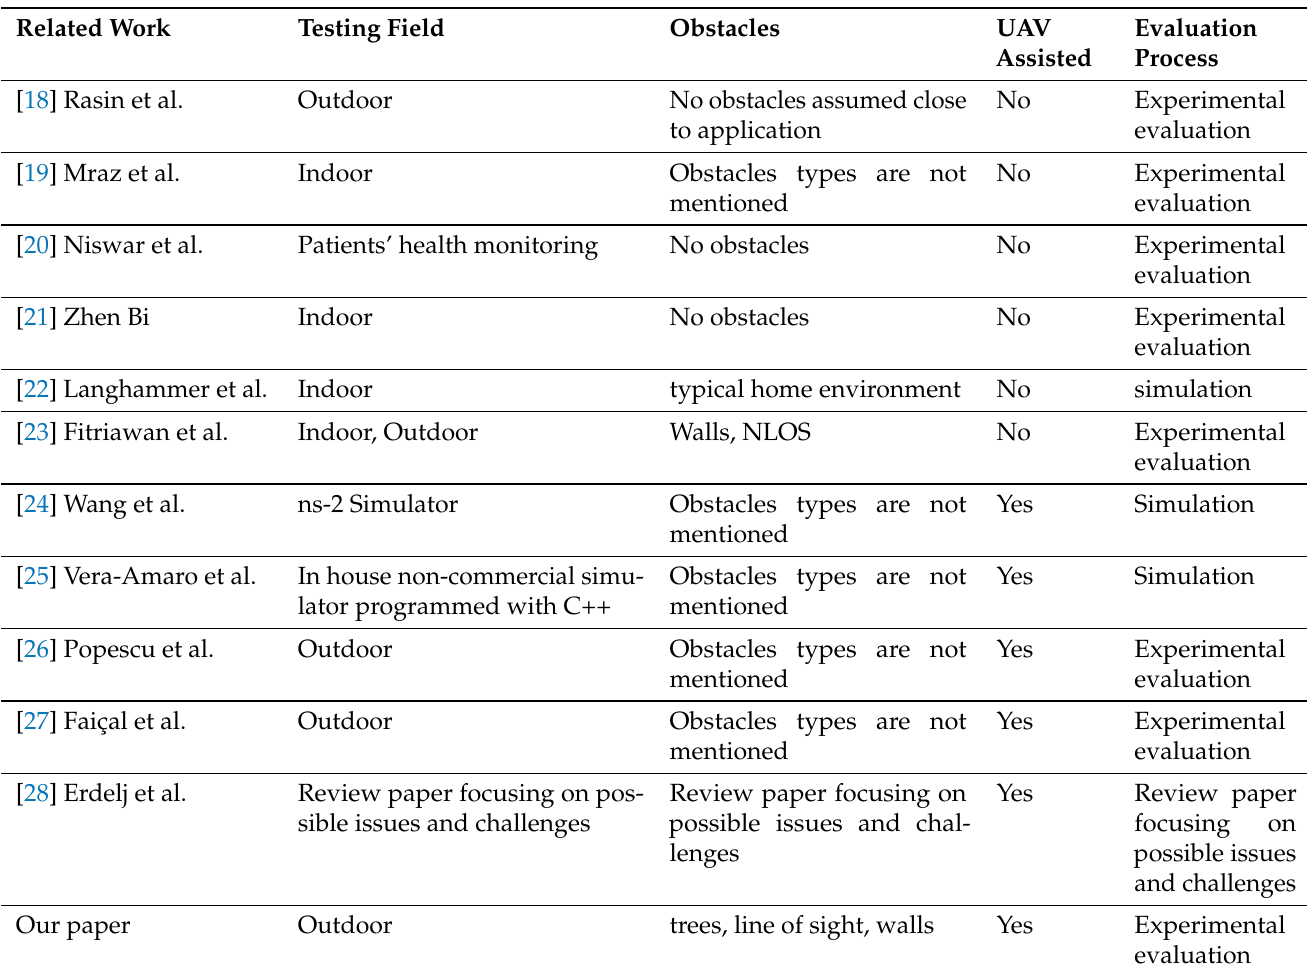
Table 1. A comparison table with related